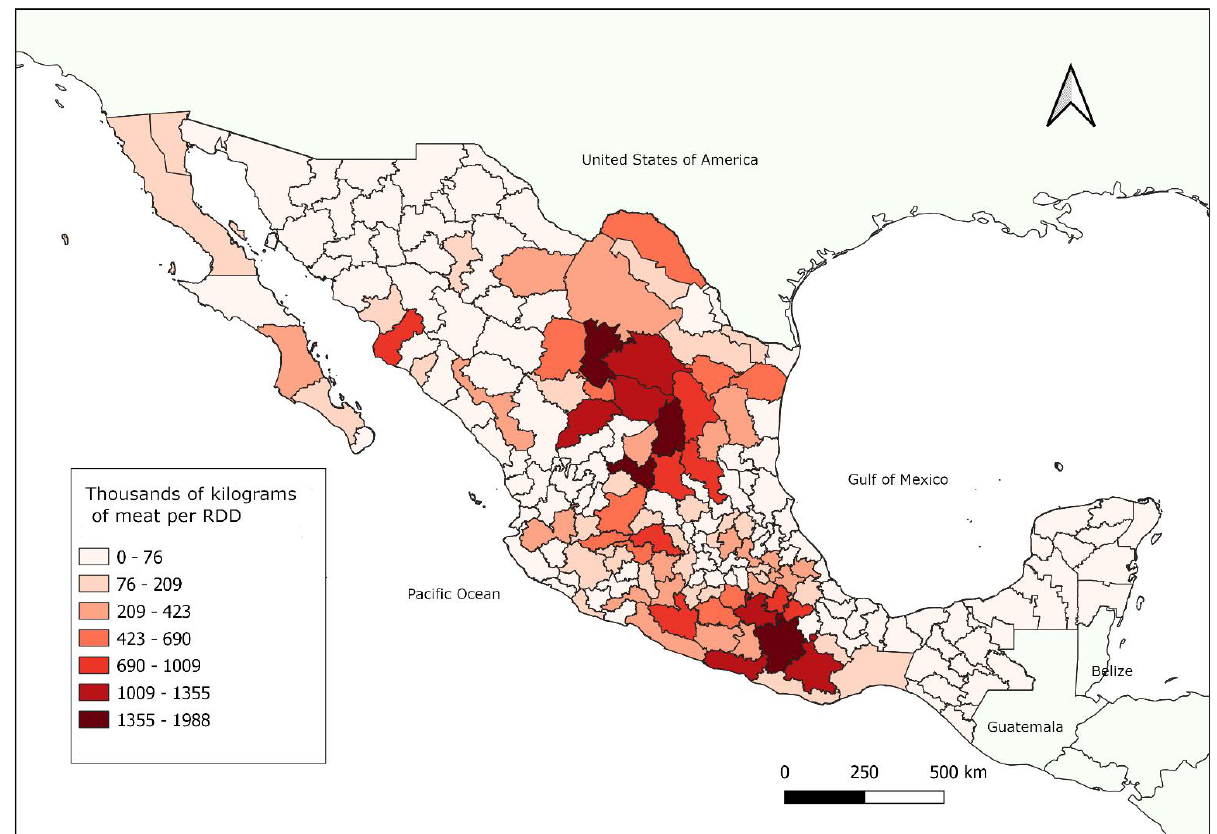
Figure 1. Distribution of goat meat production in Mexico by Rural Development Districts (RDD or DDR for its acronym in Spanish). There is an important concentration of systems (mostly extensive or semi-intensive) related to meat production in north and south Mexico. The main products are known as cabrito and mole de caderas . The Secretariat of Agriculture and Rural Development divides Mexico into 191 districts, according to geographic, social, and environmental factors that promote connection between the state, local farmers, and municipalities.